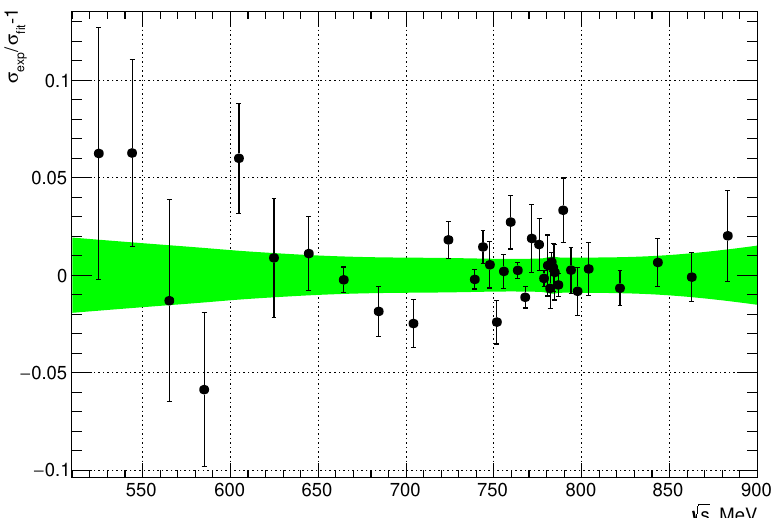
Figure 13 . The relative di(cid:11)erence between the measured e + e (cid:0) ! (cid:25) + (cid:25) (cid:0) cross section and the (cid:12)t curve.